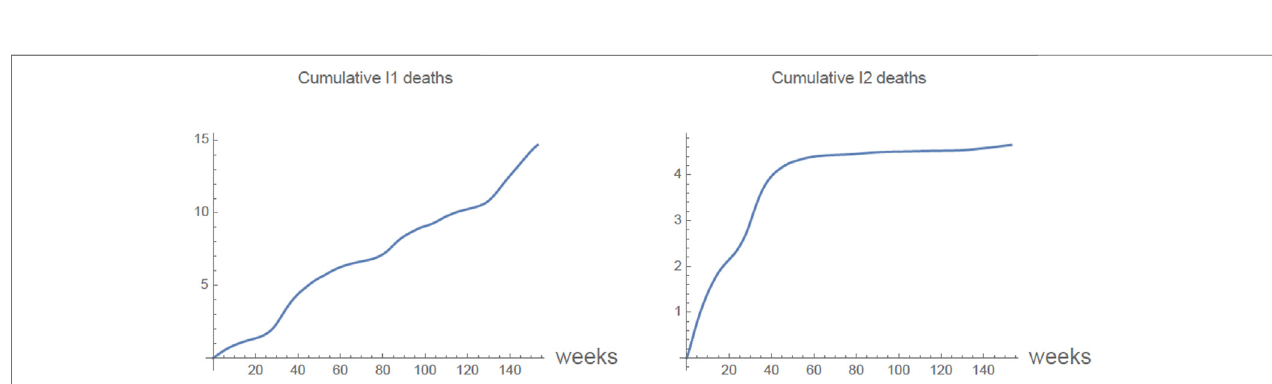
FIGURE 8 | None of the 875,000 9 years olds are vaccinated. Top graph: cumulative total number of all deaths each week of the 875,000 (unvaccinated) 9 years olds.Thereddotscorrespondtoascalingofthereportedcasedatafortotalcasesofallages[8].Thescalingaccountsforthetotaldeathsofthe875,0009 yearsoldsin the population (the scaling factor is 0.014 as in Figure 4 ). Middle graph: cumulative total secondary infected deaths. Bottom graph: cumulative total primary infected deaths.